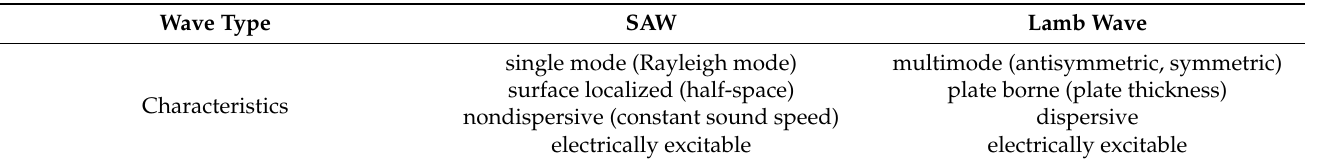
Table 1. Comparison between the SAW and Lamb-wave characteristics. Wave Type SAW Lamb Wave single mode (Rayleigh Characteristics